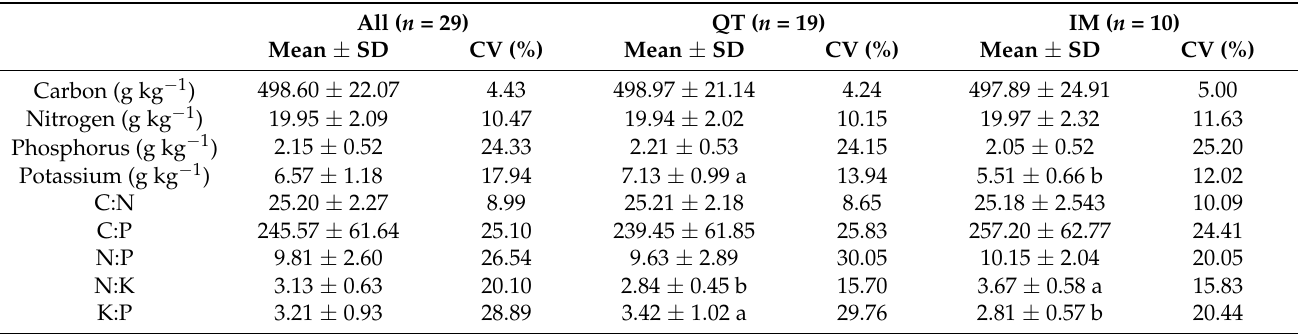
Table 1. Regional S. chamaejasme leaf ecological stoichiometry. SD is the standard deviation and CV is the coefficient of variation. Differences between QT and IM were tested using independent t -test; significant differences at p < 0.05 are indicated by different letters.